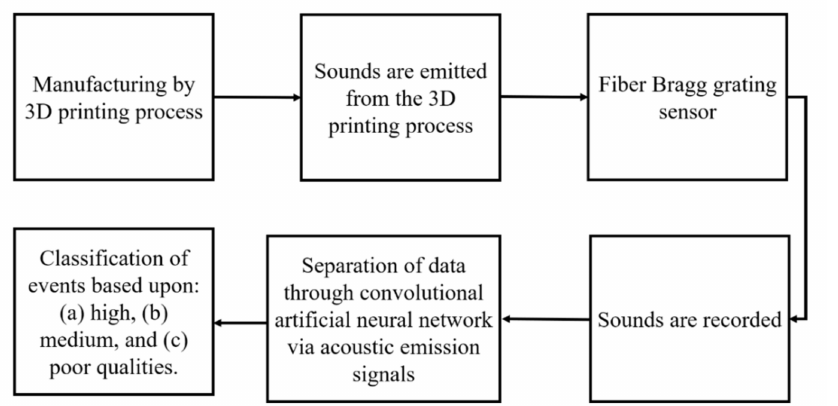
Figure 9. Schematic of the workflow used to monitor the quality during the printing process; based on the data from